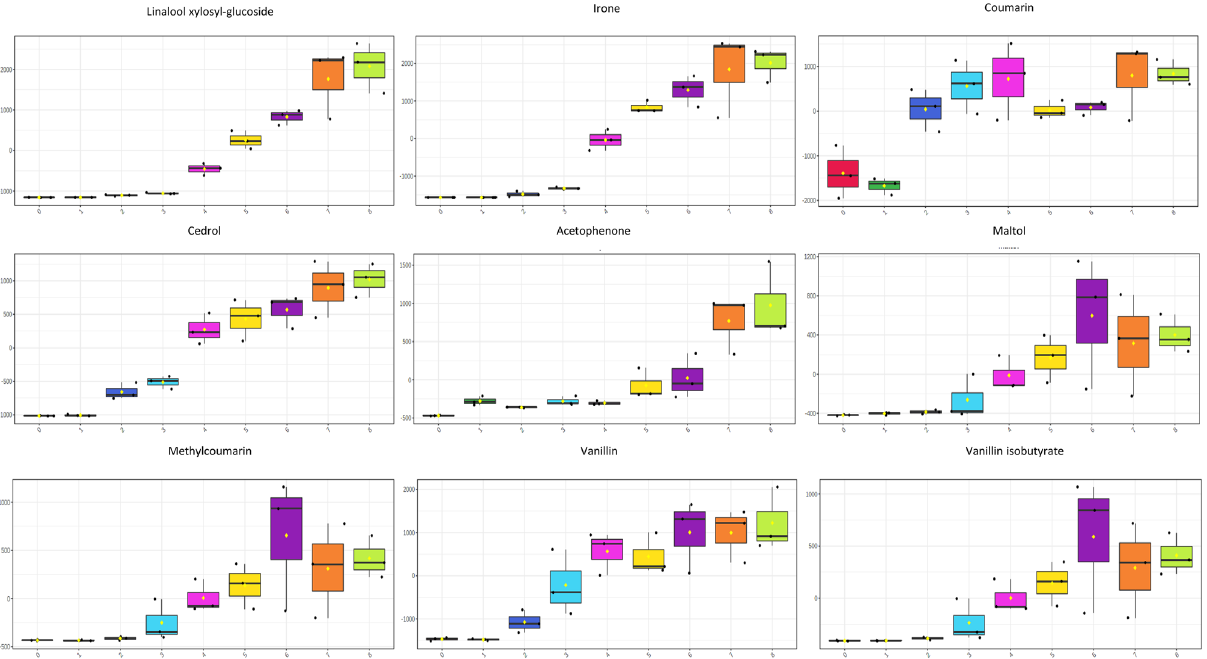
Figure 7. Box plots of metabolites linked with fine-flavor cocoa sensorial notes significantly differ throughout fermentation days (one-way ANOVA correcting for false discovery rate, FDR). Linalool xylosyl-glucoside (fruity, floral), irone (floral), coumaric acid (floral), cedrol (floral, woody,sweet), acetophenone (floral), maltol (caramel, fruity), methylcoumarin (fruity,floral), vanillin (vanilla, chocolate), and vanillin isobutyrate (caramel, chocolate, fruity).